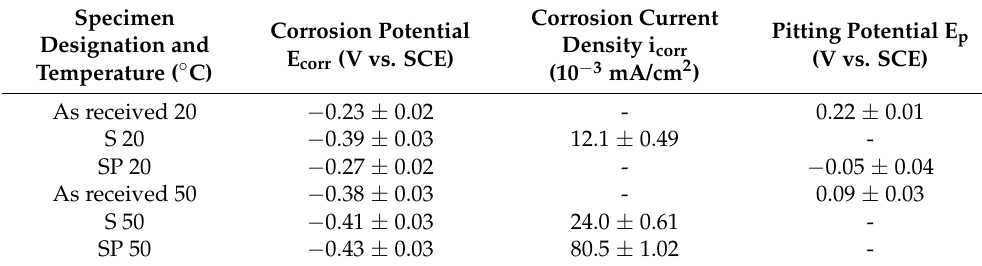
Table 5. Values of the potentiodynamic polarization